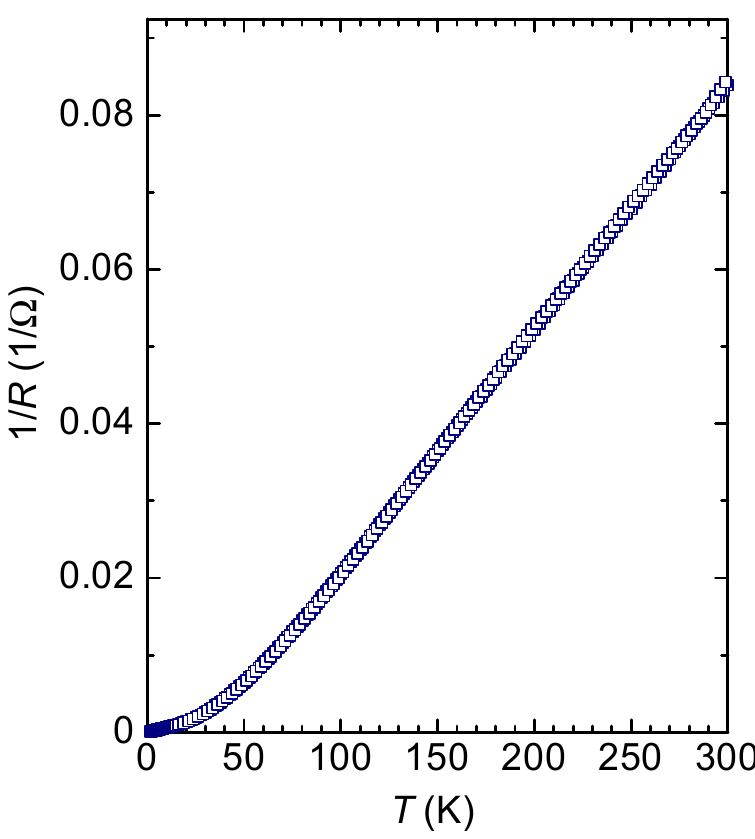
Figure 13. 1/ R ( ∝ σ ) as a function of temperature, replotted from Figure 12a. The two ranges of 3D-VRH in Figure 12b, suggest that intra-molecular electron hopping occurs mainly at low temperatures, while inter-domain and inter-layer electron